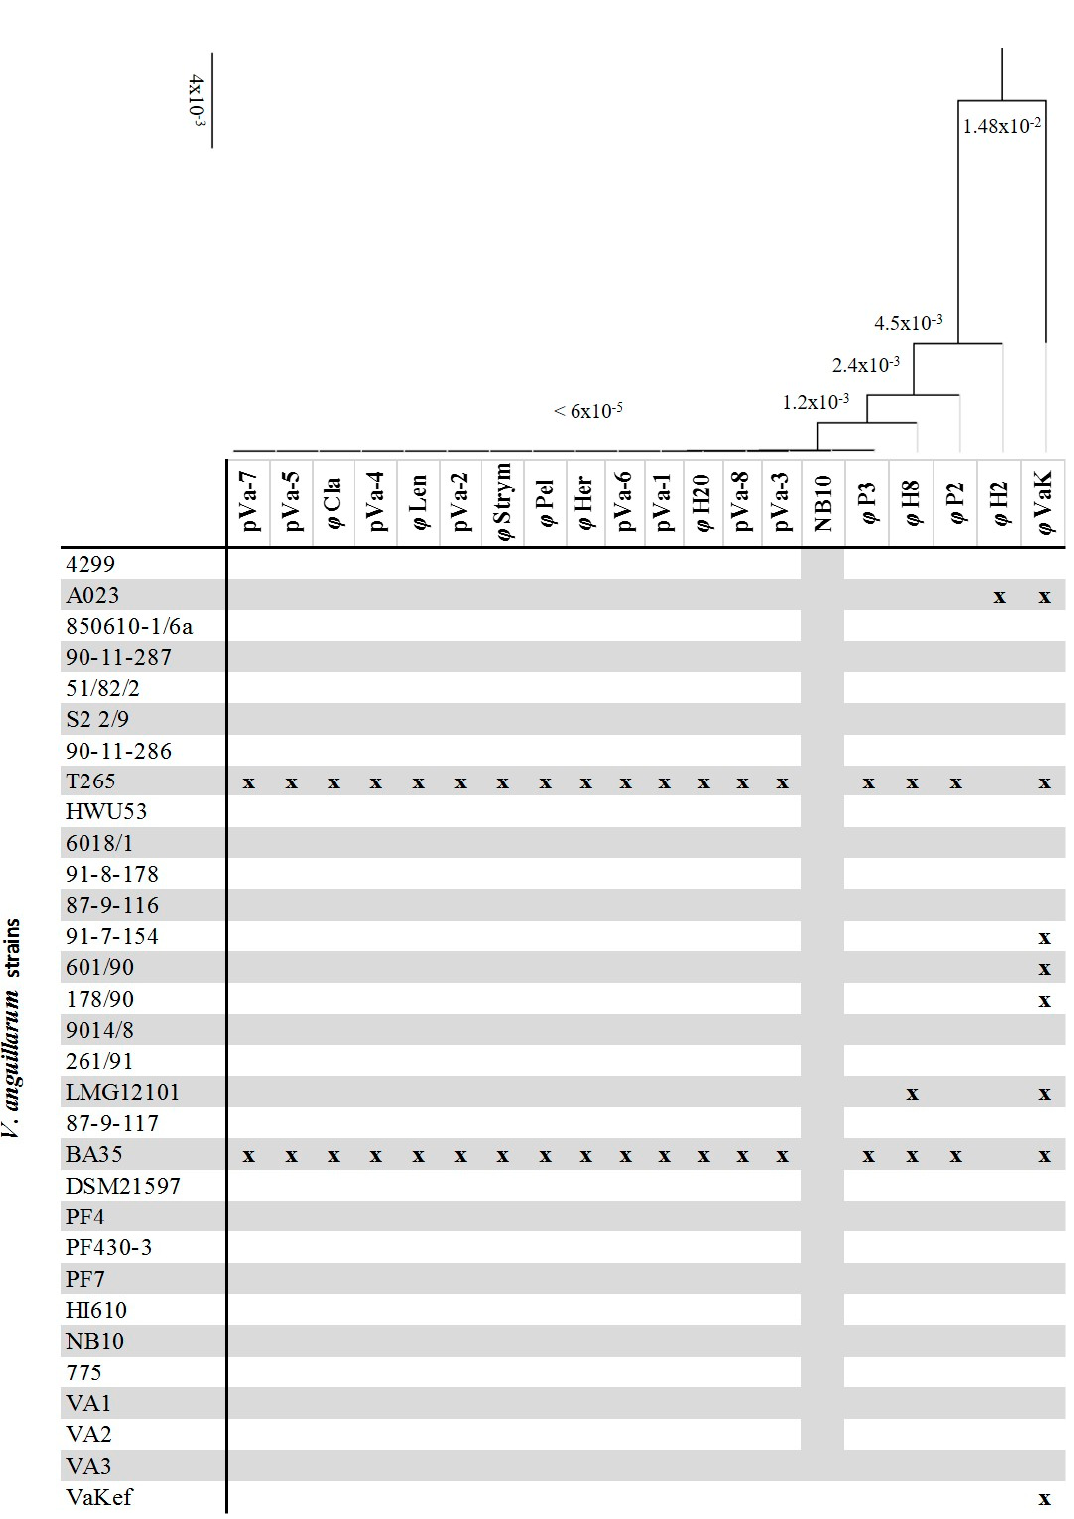
Figure 2. Host range of the 19 bacteriophage isolates against 31 pathogenic V. anguillarum strains. Blocks marked with x, indicate the infection of the bacteria by the corresponding bacteriophage isolate. The phylogenetic tree based on the whole genomes of the 19 sequenced phages of the current study (Neighbor-Joining method). The prophage from V. anguillarum strain NB10 was included as a reference phage. The branch labels indicate the substitutions per site.